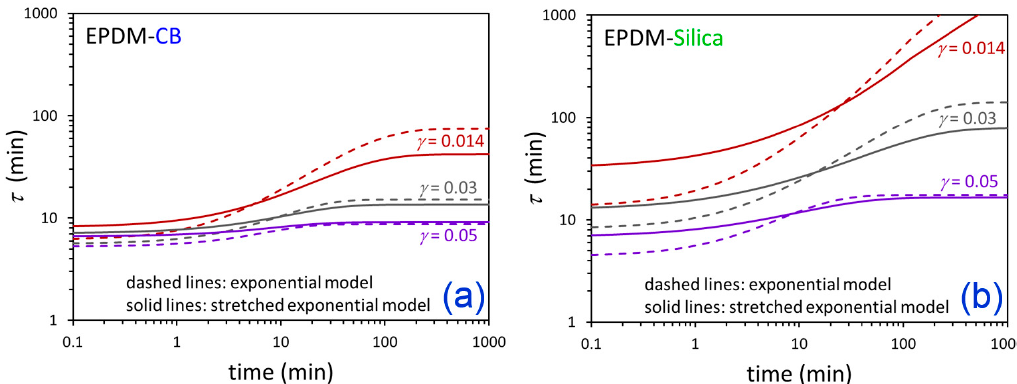
Figure 9. Time-dependent τ from fictive strain model fits for down-jump experiments from equilibrium at γ = 0.25 to the indicated γ values for EPDM-CB ( a ) and EPDM-Silica ( b ). The dashed lines are from the exponential model and the solid lines are from the stretched exponential model.